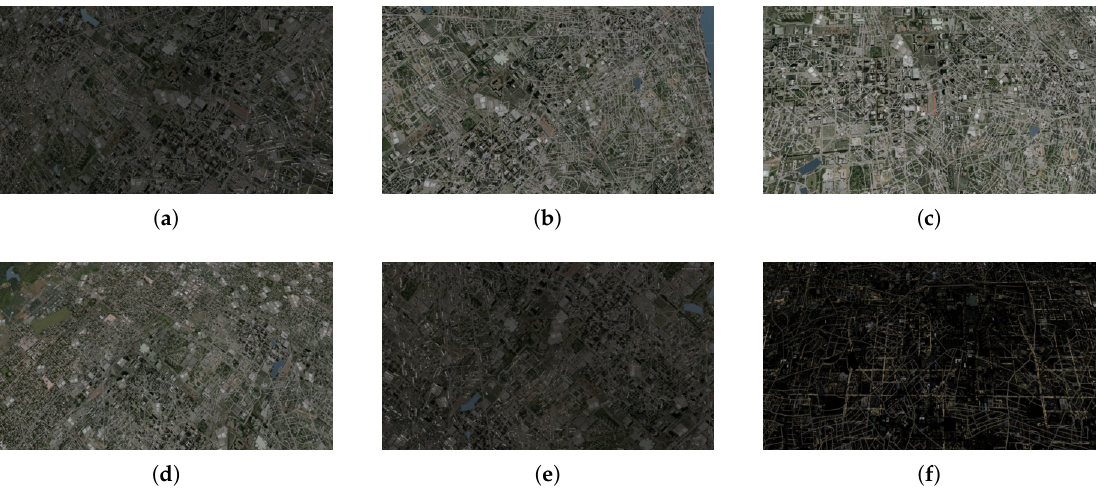
Figure 9. Selected frames from test videos in group 1: ( a ) 6:00, ( b ) 9:00, ( c ) 12:00, ( d ) 15:00, ( e ) 18:00, ( f )